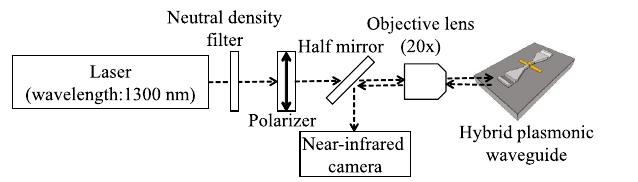
Figure 8. Schematic of the experimental setup to evaluate the fabricated structure. The wavelength of incident light is 1300